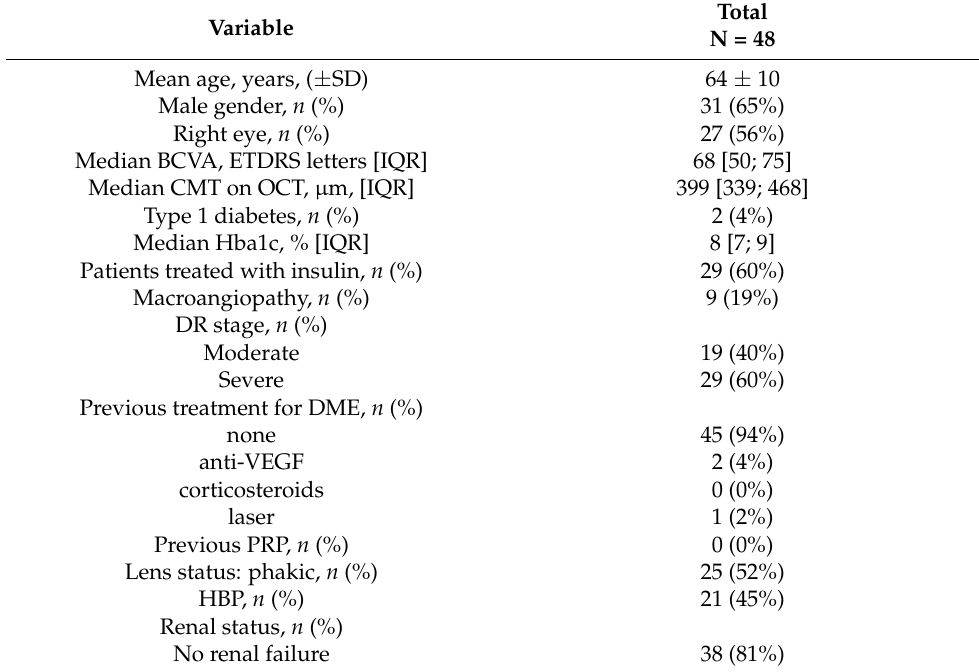
Table 1. Patients’ baseline